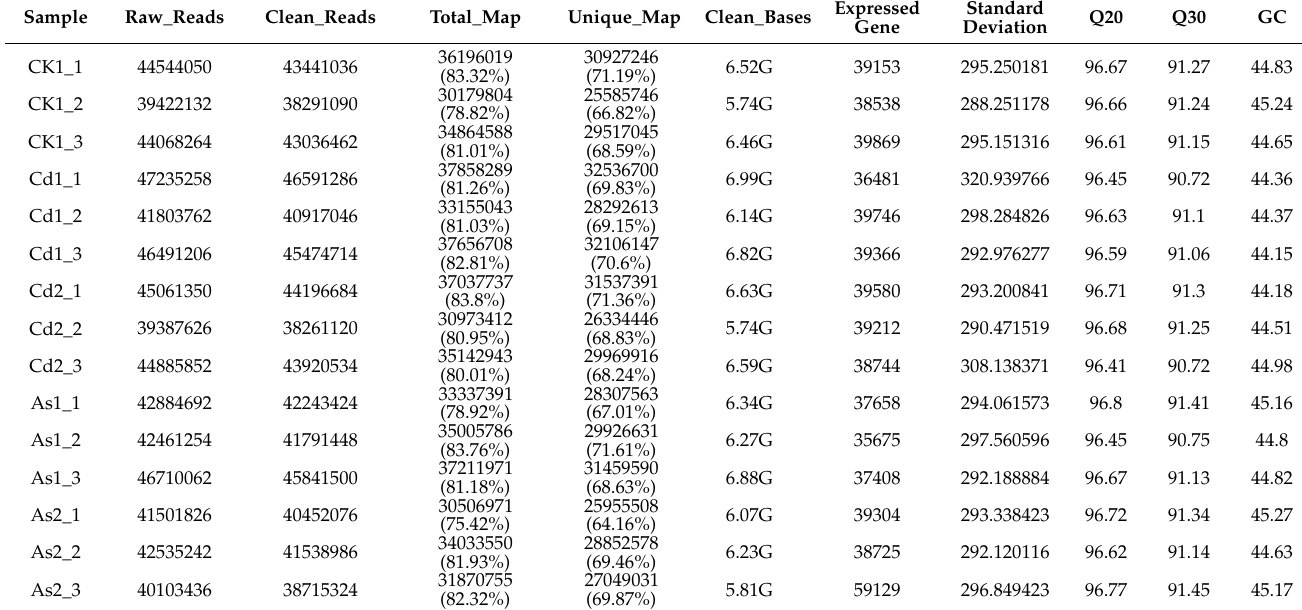
Table 1. Summary statistics of RNA-seq results in Cd/As-treated tea